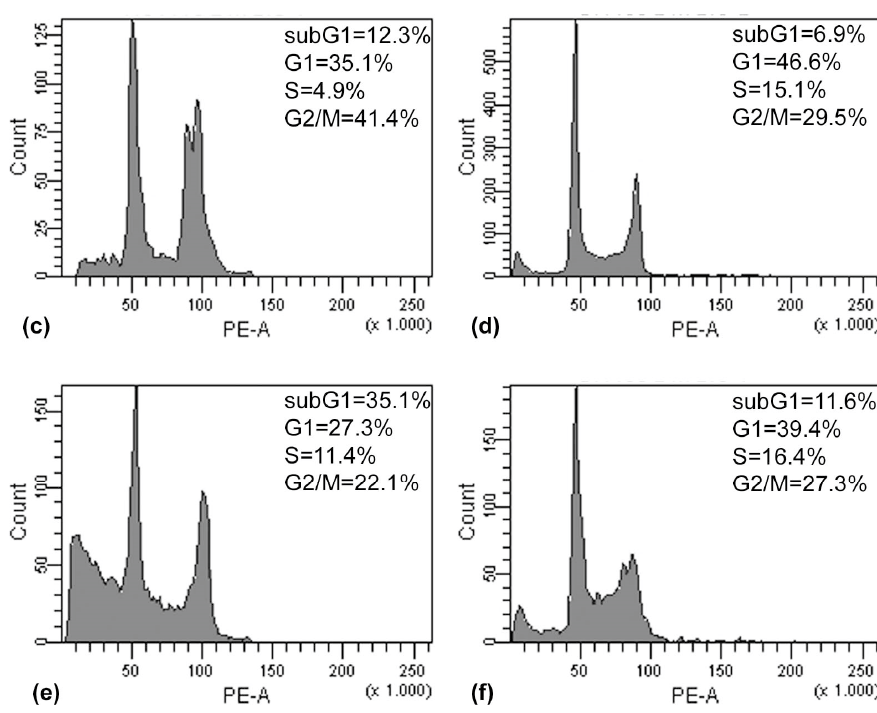
Figure 6. Cell cycle analysis on HCT116 and SW480 cells by DNA labeling with Propidium Iodide (PI). HCT116 control cells ( a ) treated with (PsT 5 mg/mL + NAC) ® ; ( c ) (PsT 10 mg/mL + NAC) ® ; ( e ) for 24 h. SW480 control cells ( b ) treated with (PsT 5 mg/mL + NAC) ® ; ( d ) (PsT 10 mg/mL + NAC) ® ; ( f ) for 24 h. Histograms are representative of three independent experiments.